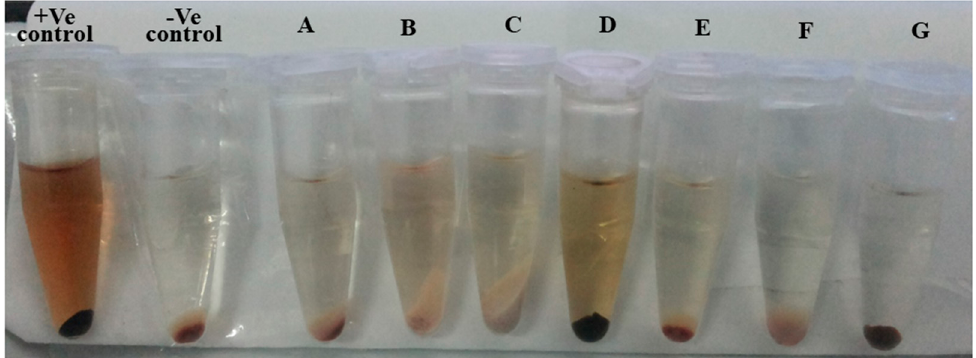
Figure 19. Optical images of hemolysis assay.